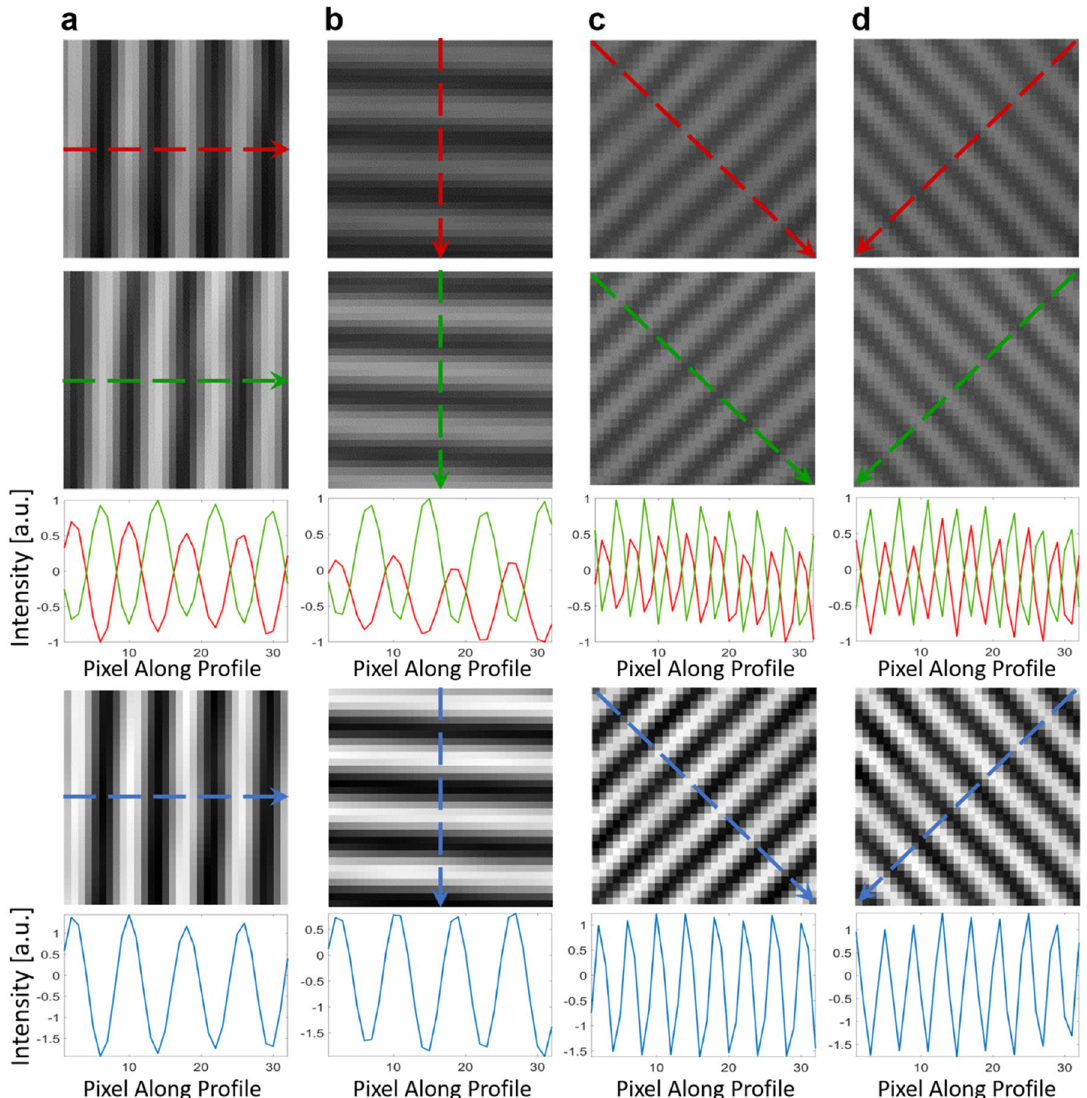
Figure 2. Subtraction of the complementary fringe patterns to produce a background-corrected and noise- reduced fringe pattern. ( a ) Images of a vertical fringe pattern, ( b ) horizontal fringe pattern, ( c ) 45-degree fringe pattern, and ( d ) 135-degree fringe pattern relative to the x-axis. From top to bottom: Images of the first complementary fringe pattern, second complementary π-phase shifted fringe pattern, color-coded intensity line profiles for the corresponding dashed lines indicated in the complementary fringe patterns, the DFP resulting from the subtraction of the first complementary fringe pattern from the second complementary fringe pattern, and the line profile for the corresponding dashed lines indicated in the